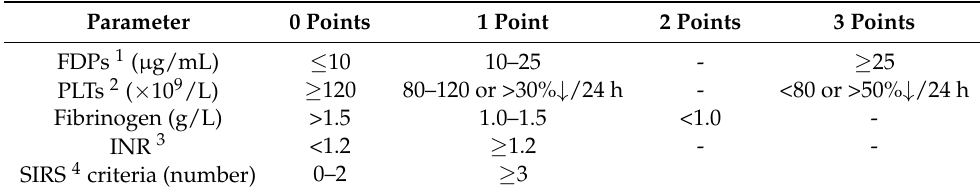
Table 3. Japanese Association for Acute Medicine disseminated intravascular coagulation diagnostic scoring system. Based on